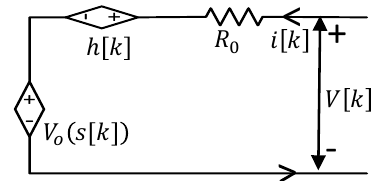
Figure 1. Equivalent circuit model of a battery for